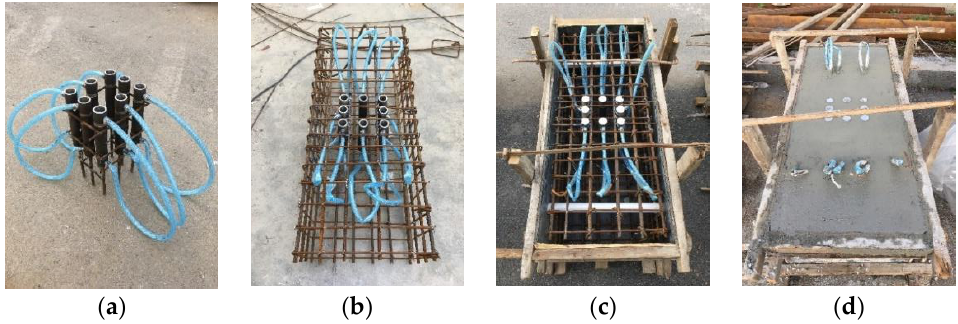
Figure 11. The main process of the base. ( a ) Fixation of grouting sleeve. ( b ) Assembling reinforcement. ( c ) Manufacture of molds. ( d ) Pouring concrete for the base.